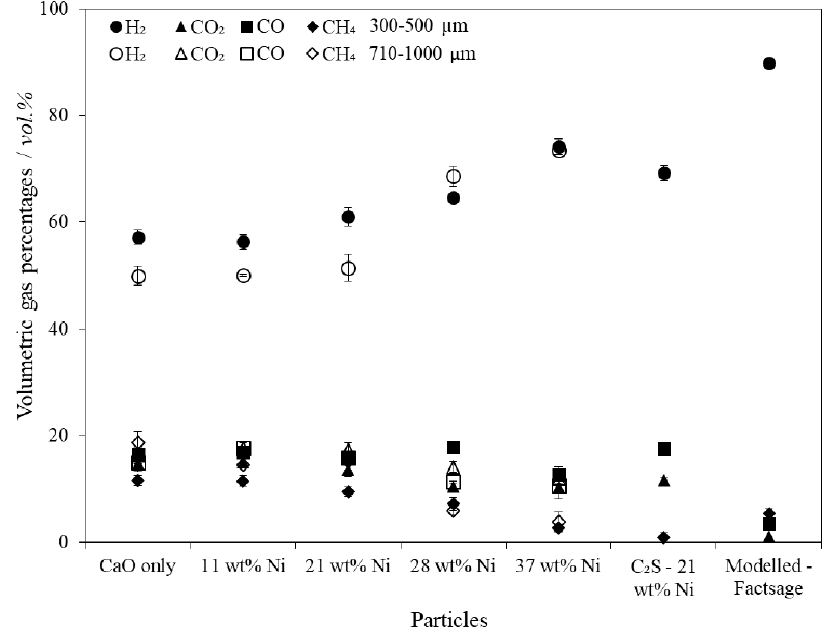
Figure 6. Volumetric gas percentages of the product gas (dry and N 2 free) averaged over the steady state period during biomass Sorption Enhanced Steam Reforming (SESR) in a fluidised bed reactor with varying compositions of combined particles.